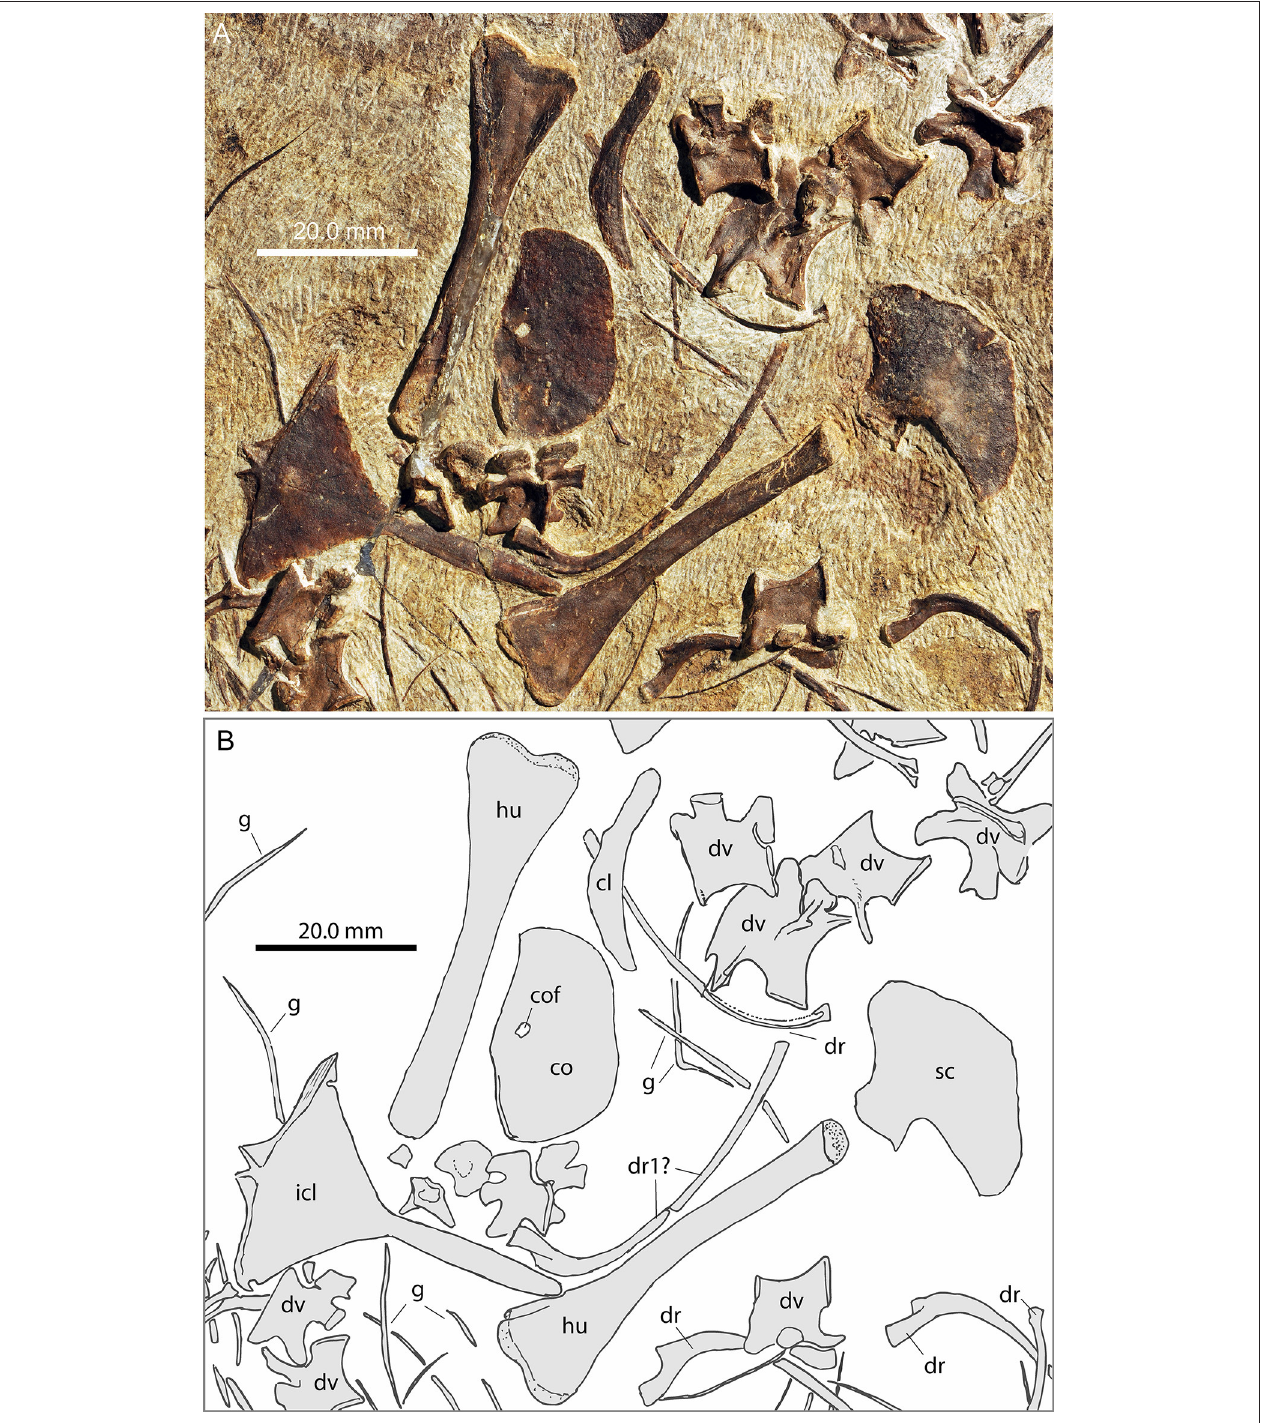
FIGURE 6 | Focus on the pectoral region of PIMUZ T 1559. (A) Photograph; (B) interpretative drawing.